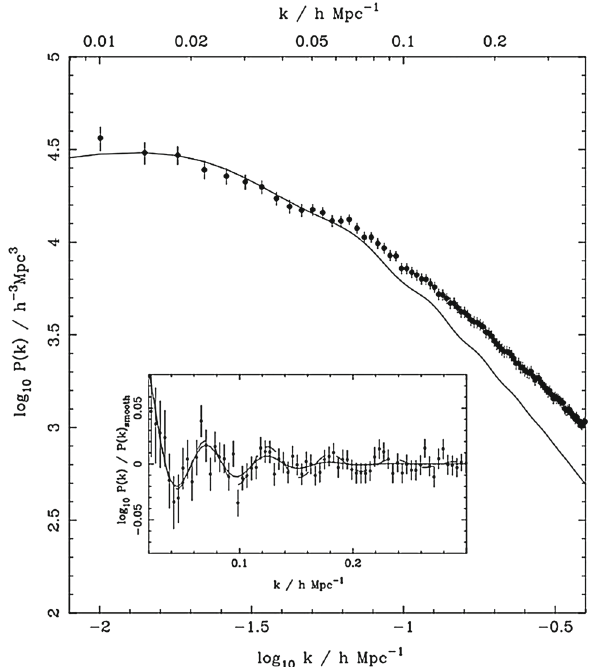
Fig. 12 Matter power spectrum form measured from SDSS (Percival et al.